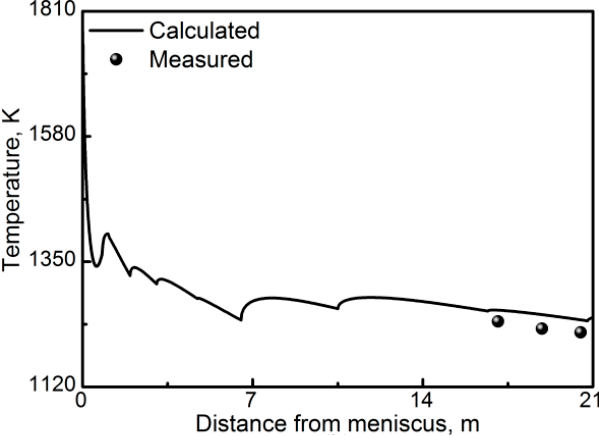
Figure 4. Slab surface temperature along the casting direction.